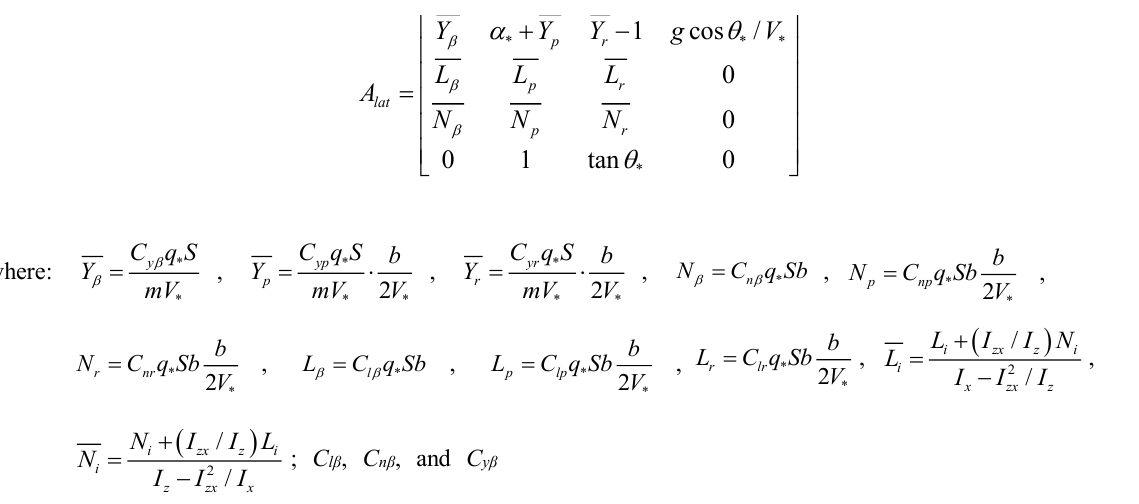
damping in roll derivatives; C lr , C nr , and C yr represent the aircraft damping in yaw derivatives; I x , I z , and I zx represent the aircraft moments of inertia (kg·m 2 ); b represents the span of aircraft (m); S represents the reference area of aircraft (m 2 ); * represents the dynamic pressure (N/m 2 );